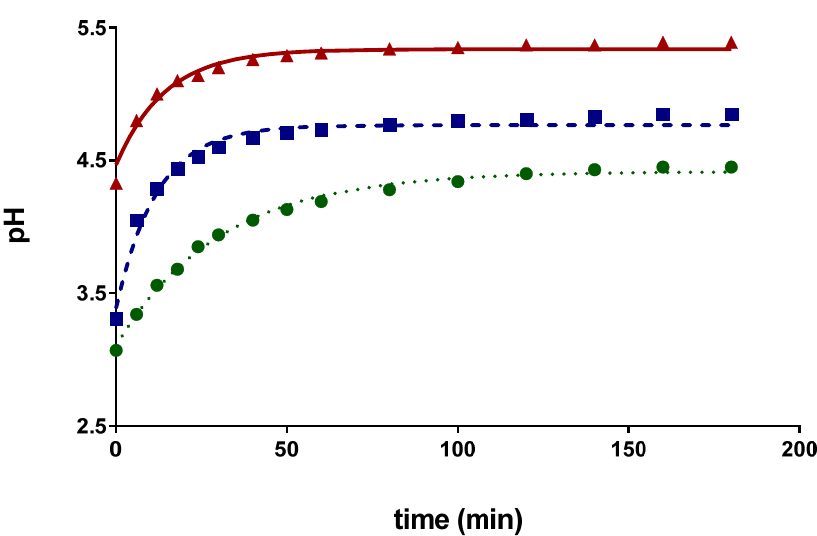
Figure 2. pH evolution during the extraction for a solid liquid ratio of ● S:L = 0.10 g/mL, ■ S:L = 0.20 g/mL, and ▲ S:L = 0.30 g/mL.